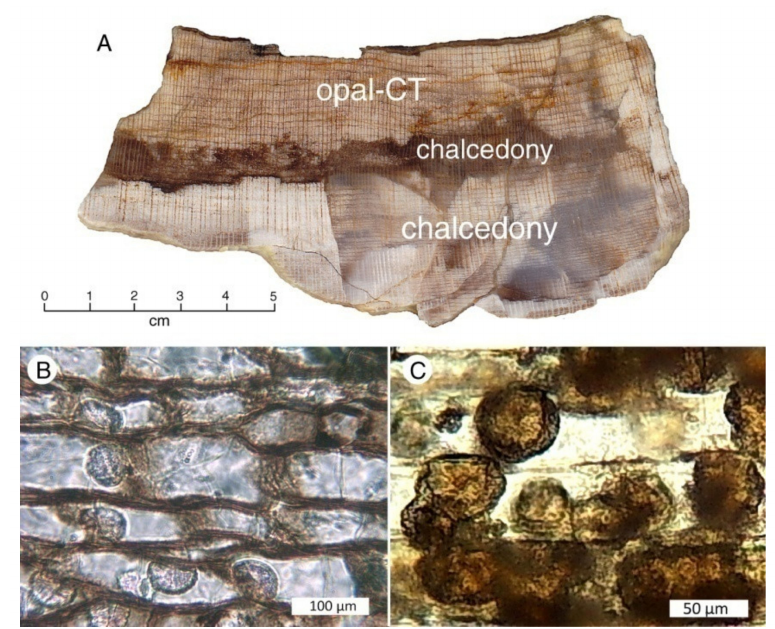
Figure 42. Coexistence of opal-CT and chalcedony in Cenozoic woods. ( A ) Miocene oak from Vantage, central Washington, USA. Opal-CT and chalcedony are present as separate zones. ( B , C ) Fossil wood where individual cells contain spherical masses of opal surrounded by chalcedony. These textures are evidence that the opal was not destroyed when the cells later became filled with microcrystalline silica. ( B ) Sequioxylon , late Eocene, Florissant Fossil Beds National Monument, Colorado, USA. Specimen courtesy of Herbert Meyer. ( C ) Miocene wood from Saddle Mountain, central Washington, USA. Specimen from Tad Dillhoff.